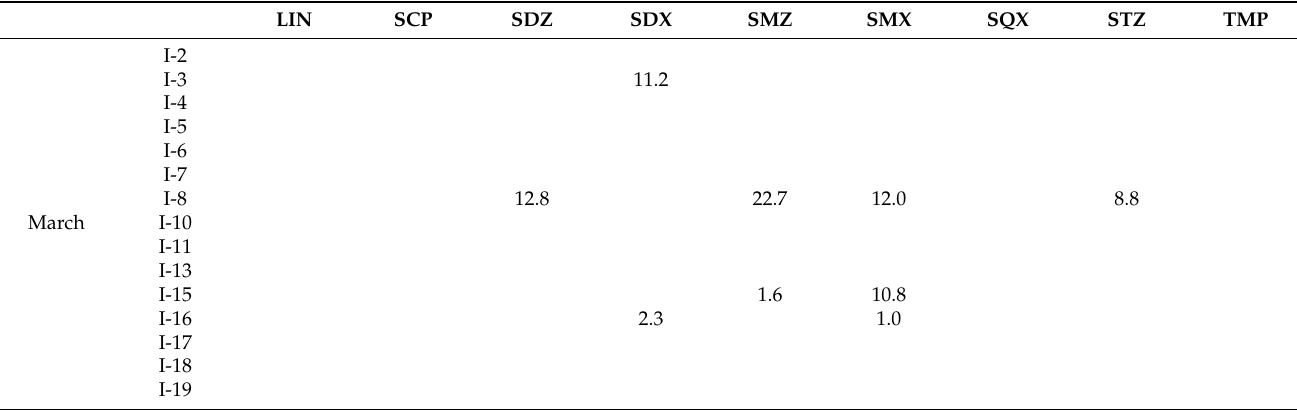
Table A4. Residual concentrations of antibiotics in the groundwater samples (ng L − 1 ). Blank cells indicate samples where no antibiotic could be